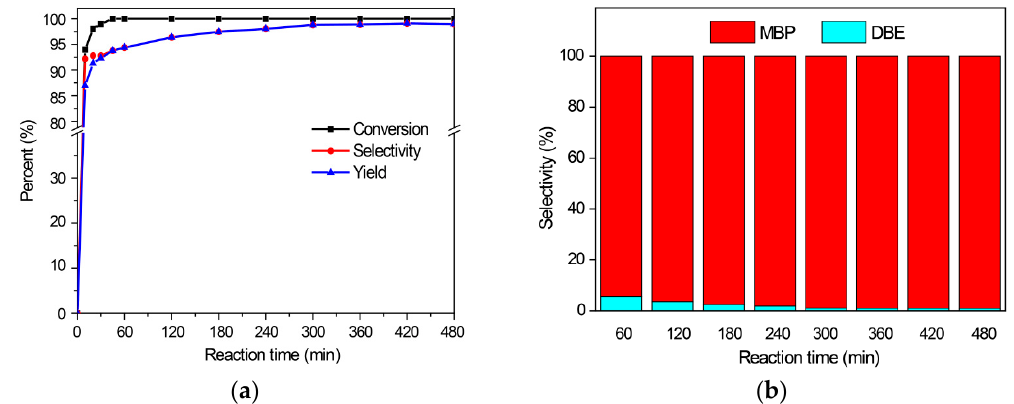
Figure 7. Benzylation of p -xylene and benzyl alcohol at 373 K. ( a ) Conversion (based on benzyl alcohol), selectivity and yield (referred to diphenylmethane). ( b ) Product distribution of mono benzylation products (MBP, 2-benzyl-1,4-dimethylbenzene in this case) and DBE.